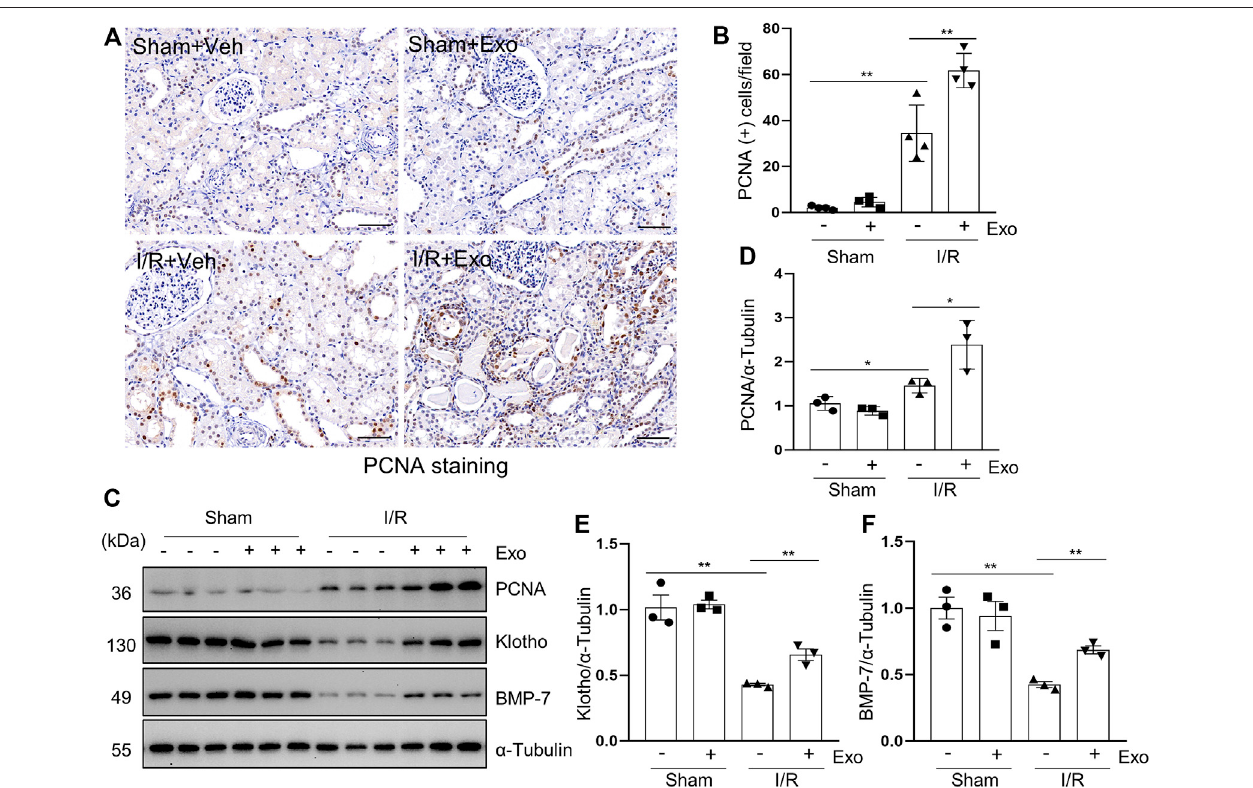
FIGURE 6 | MSCs-derived exosomes promote renal regeneration and the expression of renal protection factors. (A) Photomicrographs illustrating immunohistochemical staining of regeneration biomarker PCNA. Scale bar = 100 µm. (B) Quanti fi cation and graph of the number of PCNA positive cells from immunohistochemical staining. (C) Porcine kidney tissue lysates from four groups were subject to immunoblot analysis with speci fi c antibodies against PCNA, Klotho and BMP-7. Expression levels of PCNA (D) , Klotho (E) and BMP-7 (F) , were quanti fi ed by densitometry analysis and then normalized with α -Tubulin. Data are means ± sem.* p < 0.05; ** p < 0.01 versus sham controls.